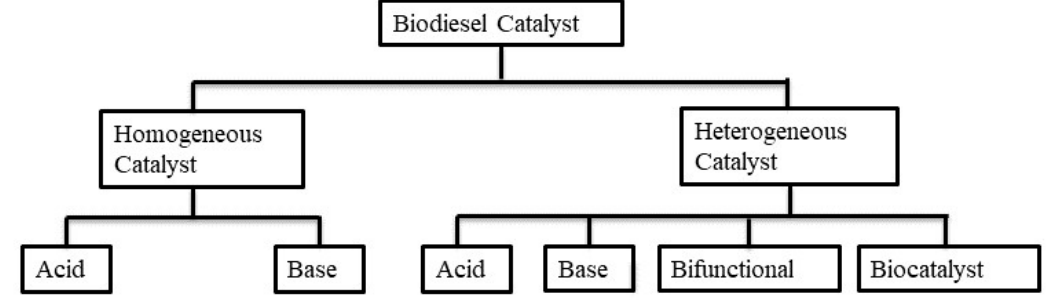
Figure 5. Catalysts used for biodiesel production.